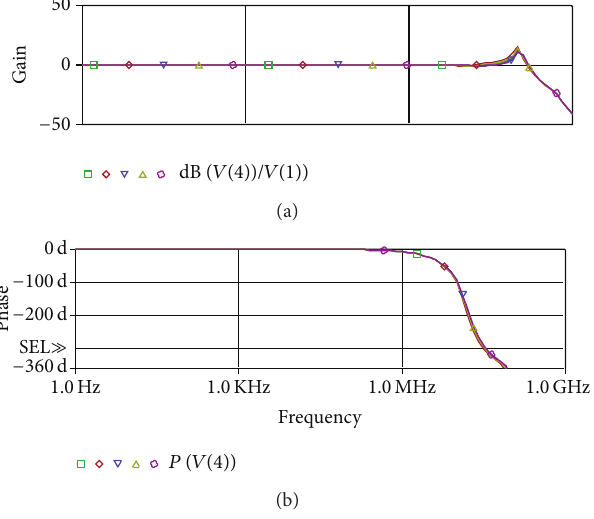
Figure 11: Monte Carlo analysis of Figure 3(a) showing gain (dB) and phase (deg) response.